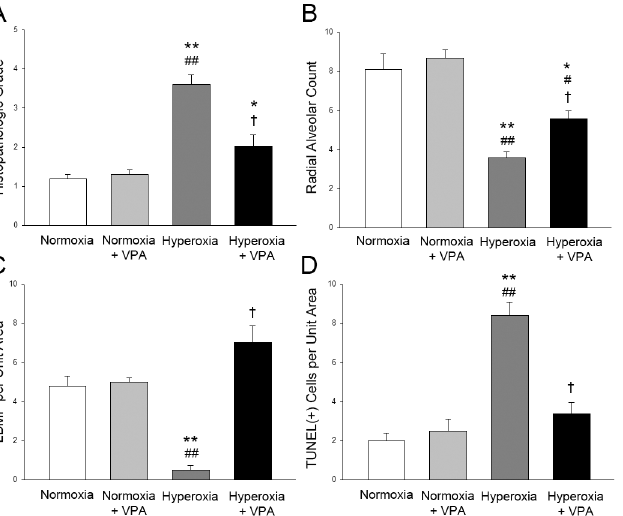
Fig 4. Bar graphs depicting Histopathologic Grade (A), Radial Alveolar Count (B), LBMP per Unit Area (C) and TUNEL(+) Cells per Unit Area (D) in lung tissues of rat pups. * p < 0.05 and ** p < 0.001 compared to Normoxia group; #p < 0.05 and ##p < 0.001 compared to Normoxia+VPA group; and † p < 0.05 and †† p < 0.001 compared to Hyperoxia group using One-Way ANOVA followed by post-hoc Tukey test.